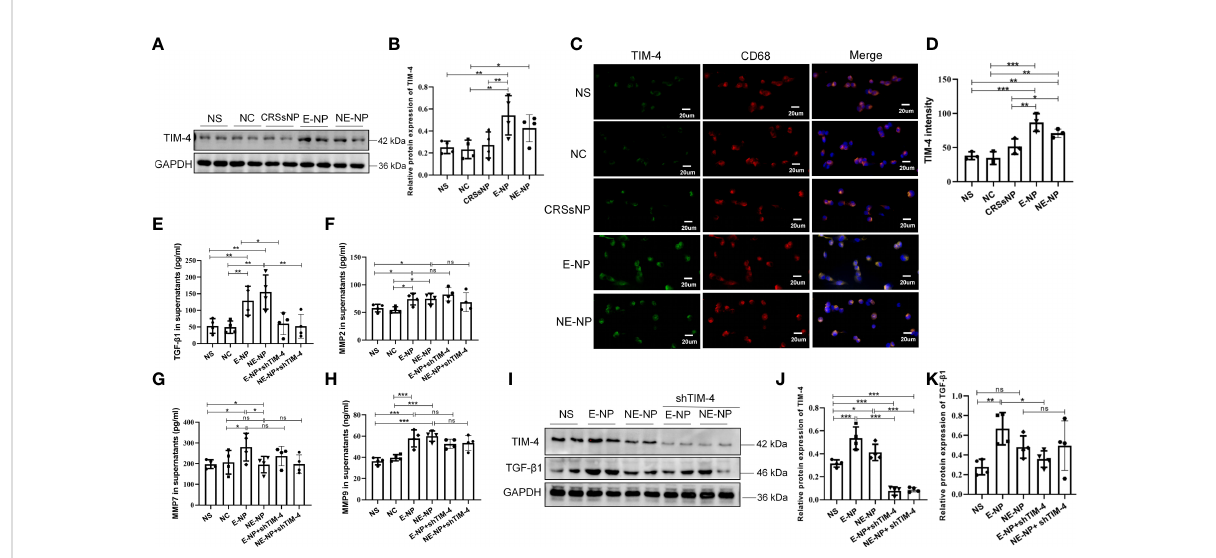
FIGURE 6 Tissue extracts promote the expression of TIM-4, TGF- b 1, MMP2, MMP7, and MMP9 in macrophages. (A) TIM-4 protein expression in THP-1 cells treated with nasal tissue extracts from healthy subjects (NC group) and patients with CRSsNP, E-CRSwNP (E-NP group), and NE-CRSwNP (E-NP group) for 24 h was measured by Western blot analysis. For each group, n=4. (B) Quantitative summary of the relative protein expression of TIM-4. (C) TIM-4 expression in THP-1 cells treated with nasal tissue extracts from NC, CRSsNP, E-NP, and NE-CRSwNP groups for 24 h was measured by immuno fl uorescence. Images show representative immunostaining for TIM-4 (green) and CD68 + macrophages (red). For each group, n=3. (D) Quantitative summary of the intensity of TIM-4 in THP-1 cells. (E-H) The TGF- b 1, MMP2, MMP7, and MMP9 levels in THP-1 cell supernatants after treatment with nasal tissue extracts from healthy people NC, CRSsNP, E-NP, and NE-CRSwNP groups for 24 h were detected by ELISA. For each group, n=4. (I) The protein levels of TIM-4 and TGF- b 1 in THP-1 cells were measured by Western blot analysis after treatment with nasal tissue extracts and TIM-4 interference, and the intensity values of the bands were normalized to GAPDH expression. For each group: n=4. (J) Quantitative summary of the relative protein expression of TIM-4. (K) Quantitative summary of the relative protein expression of TGF- b 1. Representative immuno fl uorescence images are shown at 400× magni fi cation. Bars show the mean ± SD. *P<0.05, **P<0.01,***P<0.001. ns, no signi fi